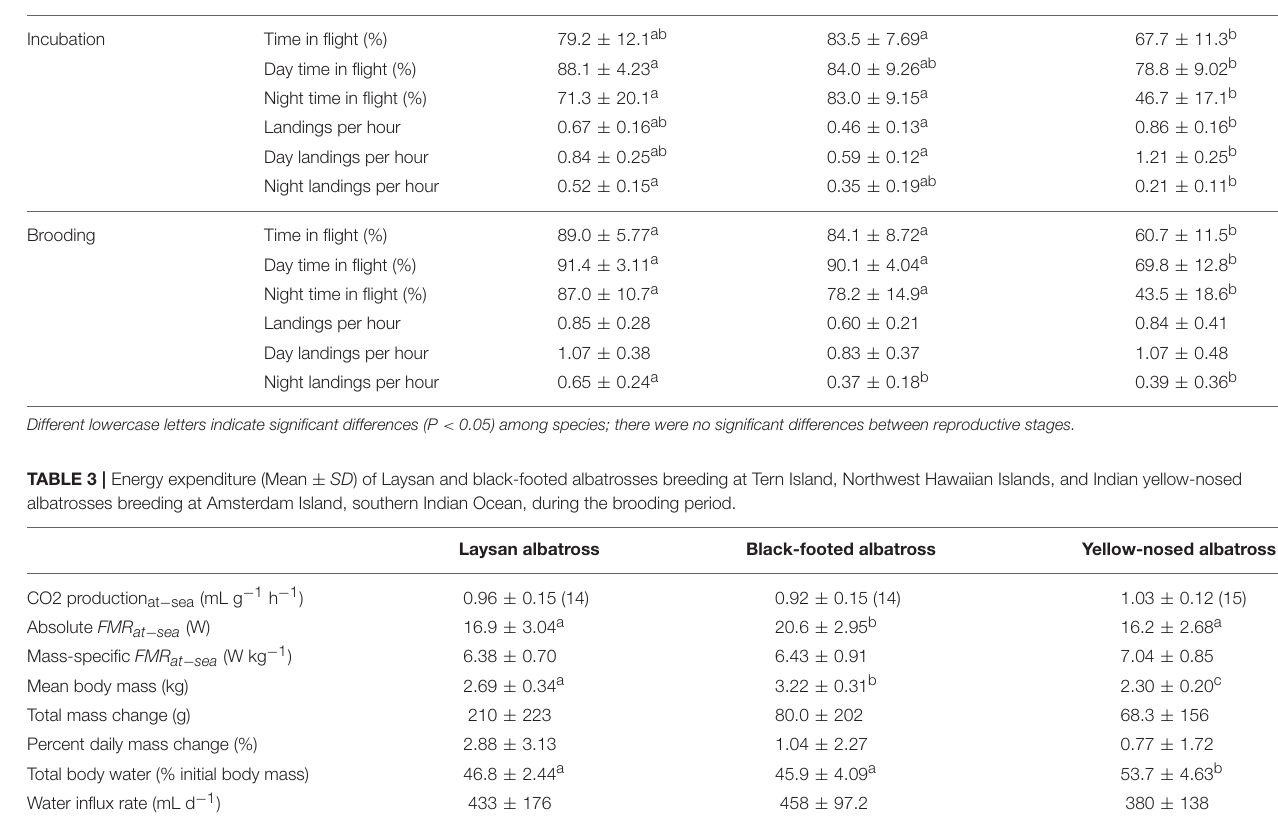
TABLE 2 | Summary characteristics (Mean ± SD ) of at-sea activity patterns of Laysan and black-footed albatrosses breeding at Tern Island, Northwest Hawaiian Islands, and Indian yellow-nosed albatrosses breeding at Amsterdam Island, southern Indian Ocean, during late incubation and brooding. Breeding period